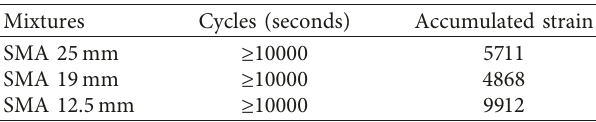
Table 4: Accumulated strain values at